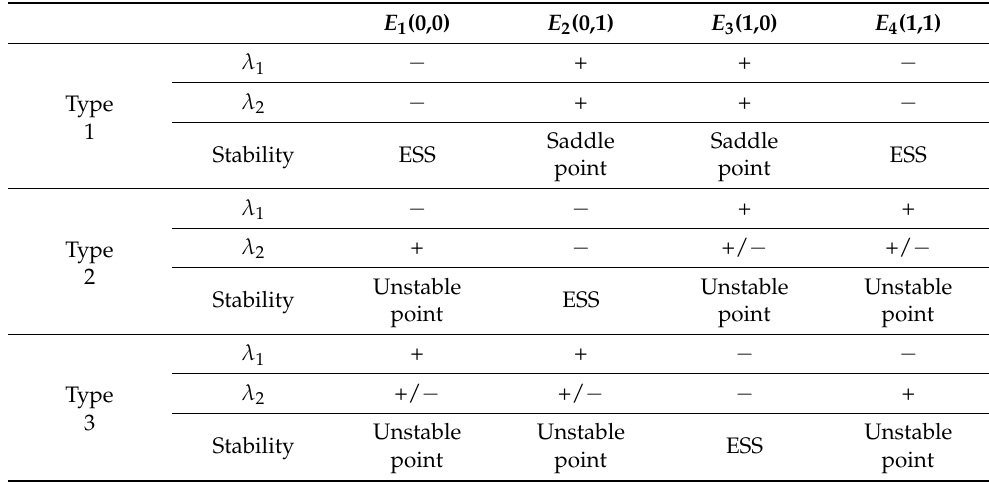
Table 4. The local stability of the equilibrium point of the evolutionary game between the enterprise and the government. E 1